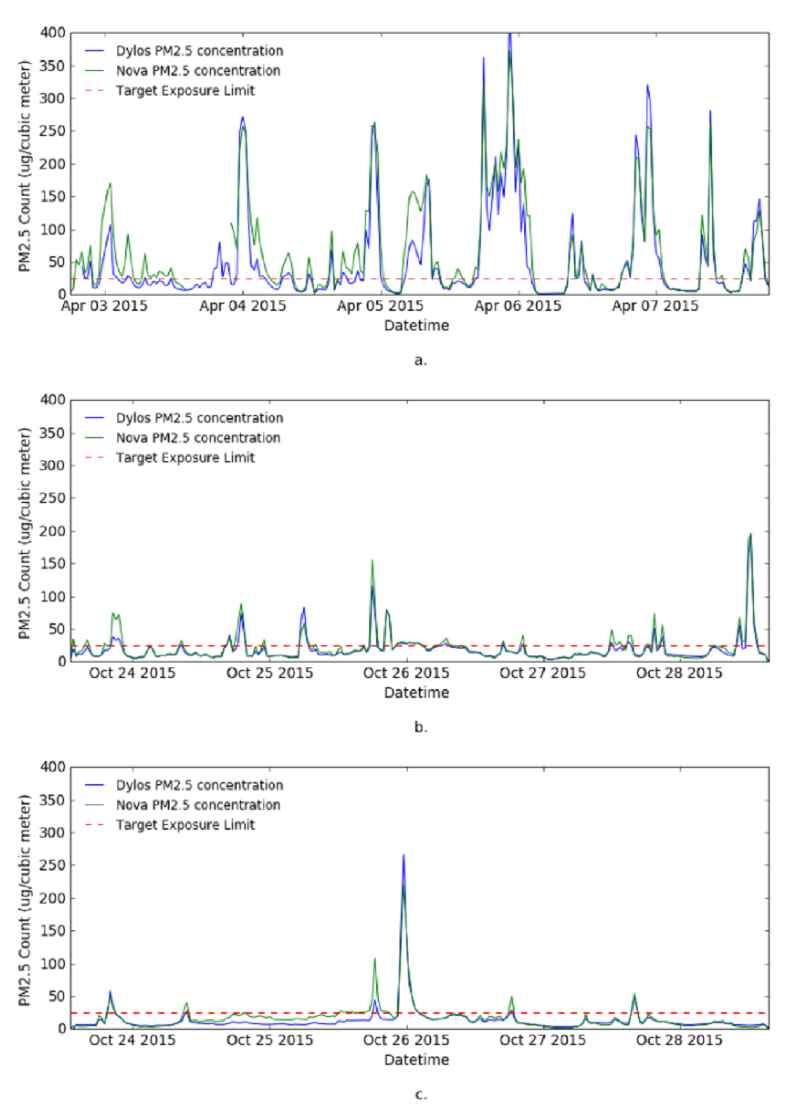
Figure 5. Line charts showing 1 min data from the monitored sites. ( a ) Site 1; ( b ) Site 2; and ( c ) Site